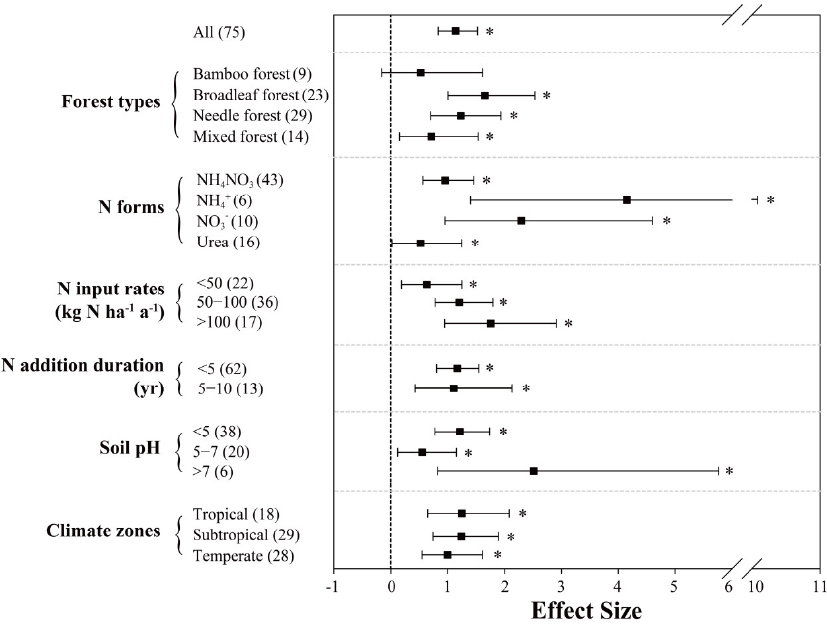
Figure 2. Effects of N inputs on forest soil N 2 O emissions in China. Error bars represent 95% confidence intervals (CI). The vertical dashed line indicates effect size = 0. If the 95% CI does not overlap with zero, the effect of N input is considered as statistically significant and denoted by * in the figure. From top to bottom are the results of subgroups, including “forest types, N forms, N input rates (kg N ha − 1 yr − 1 ), N addition duration (yr), soil pH and climatic zones”. Numbers in parentheses represent the sample sizes.